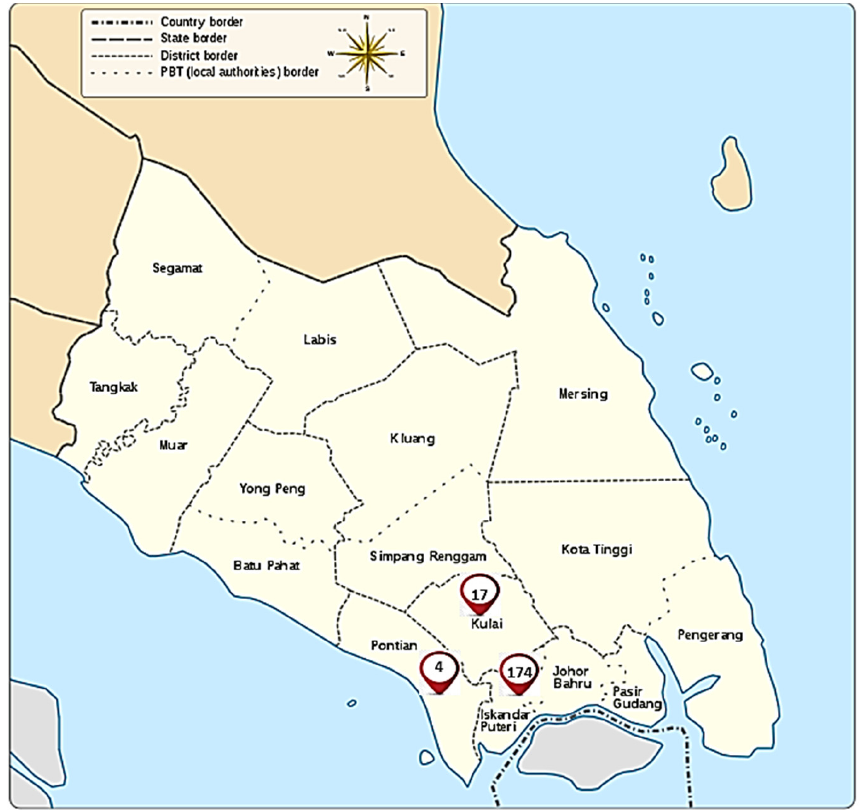
Figure 2. Data collection sites in Johor, Malaysia (https://commons.wikimedia.org/wiki/File:Districts_and_PBT_of_Johor.svg, accessed on 16 June 2021).